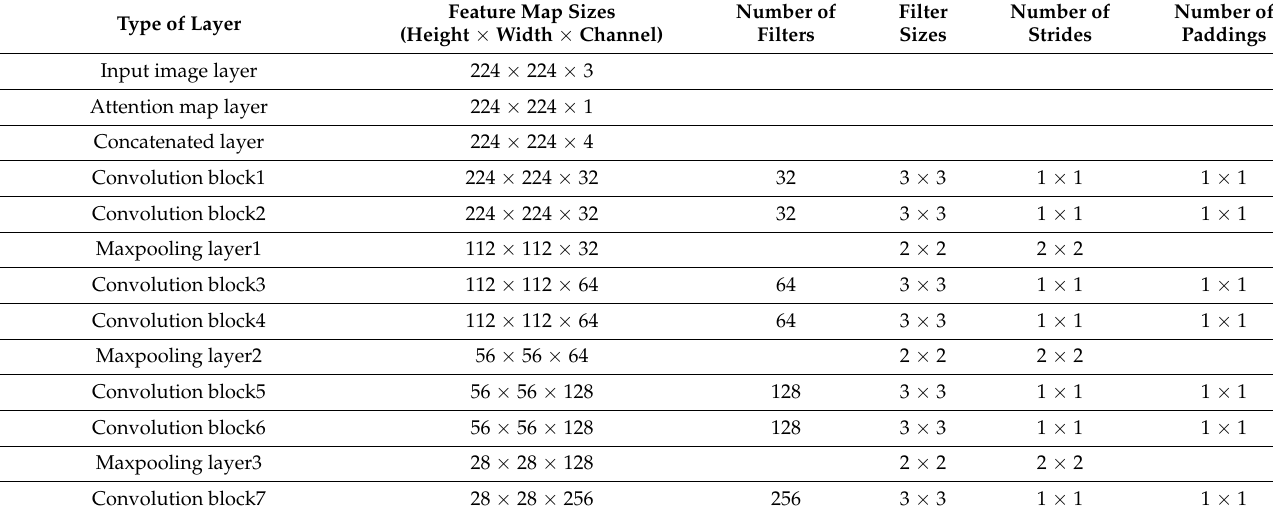
Table 2. Generator of modified EnlightenGAN (all the convolution blocks include one convolutional layer, one Leaky rectified linear unit (ReLU) layer, and one batch normalization layer, except for the last convolution block, which includes one convolutional layer and one Leaky ReLU